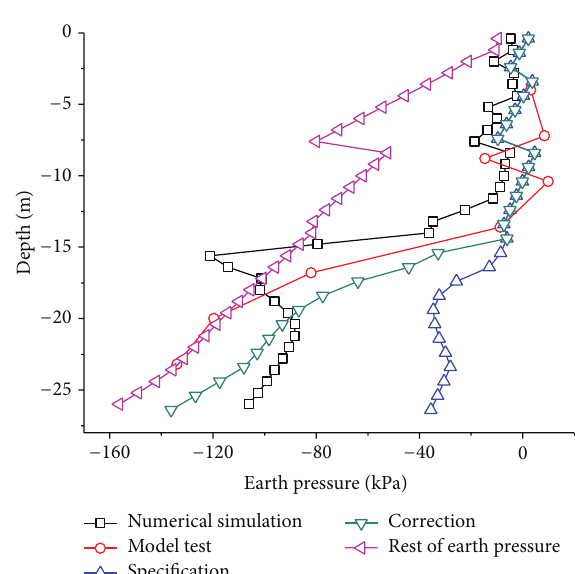
Figure 8: Earth pressure of back of front-row pile.